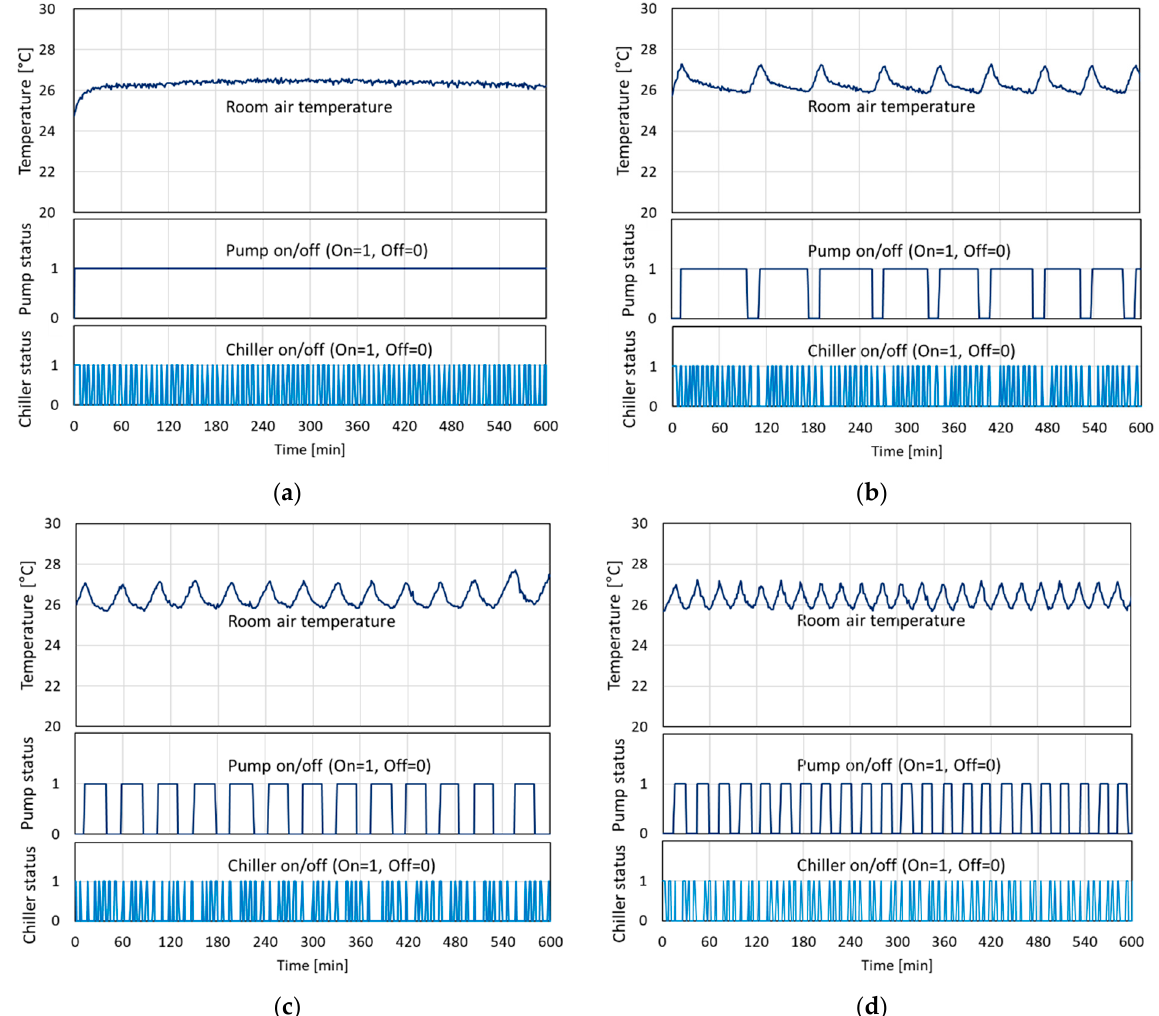
Figure 8. Measurement results of room air temperature, pump operation, and chiller operation: ( a ) Case 1; ( b ) Case 2; ( c ) Case 3; ( d ) Case 4.